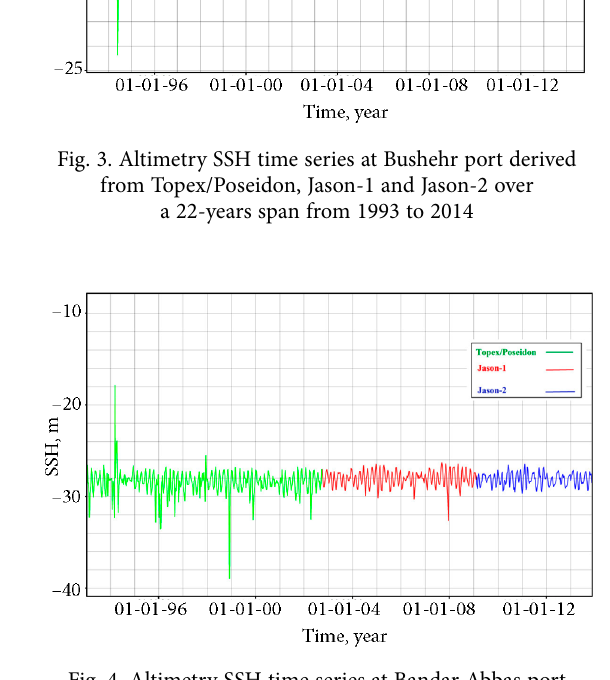
Fig. 4. Altimetry SSH time series at Bandar Abbas port derived from Topex/Poseidon, jason-1 and jason-2 over a 22-year span from 1993 to 2014